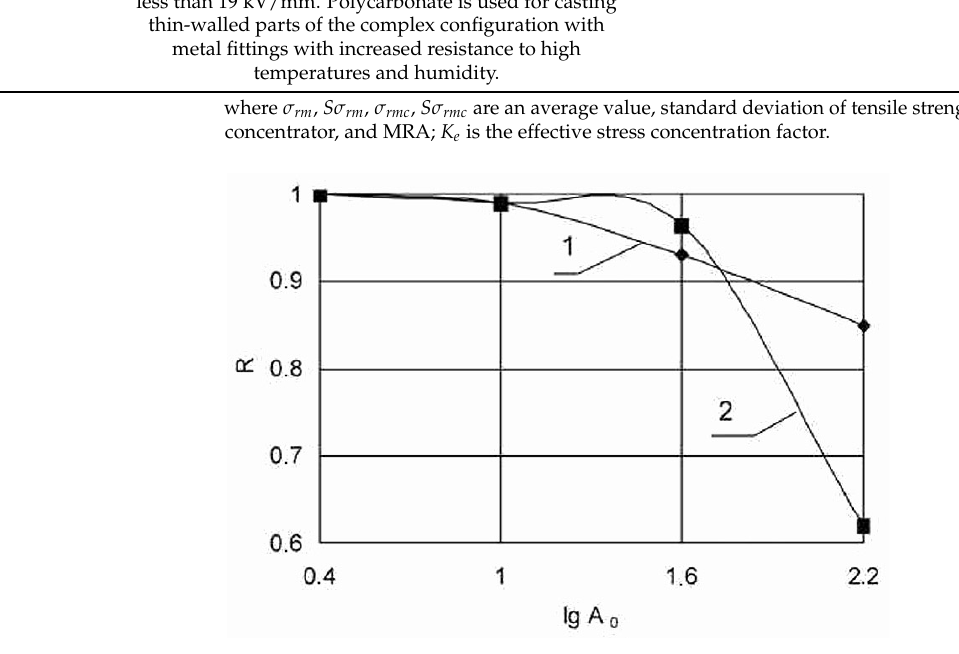
Figure 3. Dependence of the probability of the failure-free operation on lg of the cross-sectional area of the samples for thermoplastics based on polypropylene: (1) PP 21060-16, colorless; (2) PP 21060-A20.